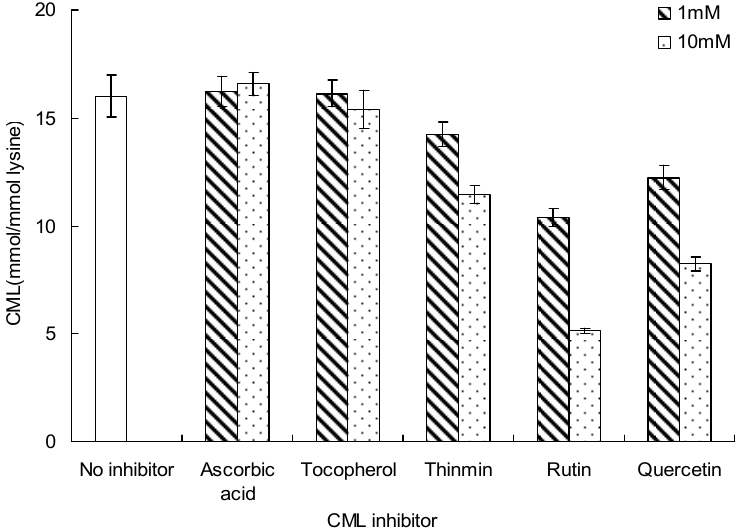
Figure 5. Inhibition of CML by vitamins and flavonoids in glucose-lysine model systems during microwave heating, at 140 °C for 20 min. Data points are the mean of triplicate measurements ±